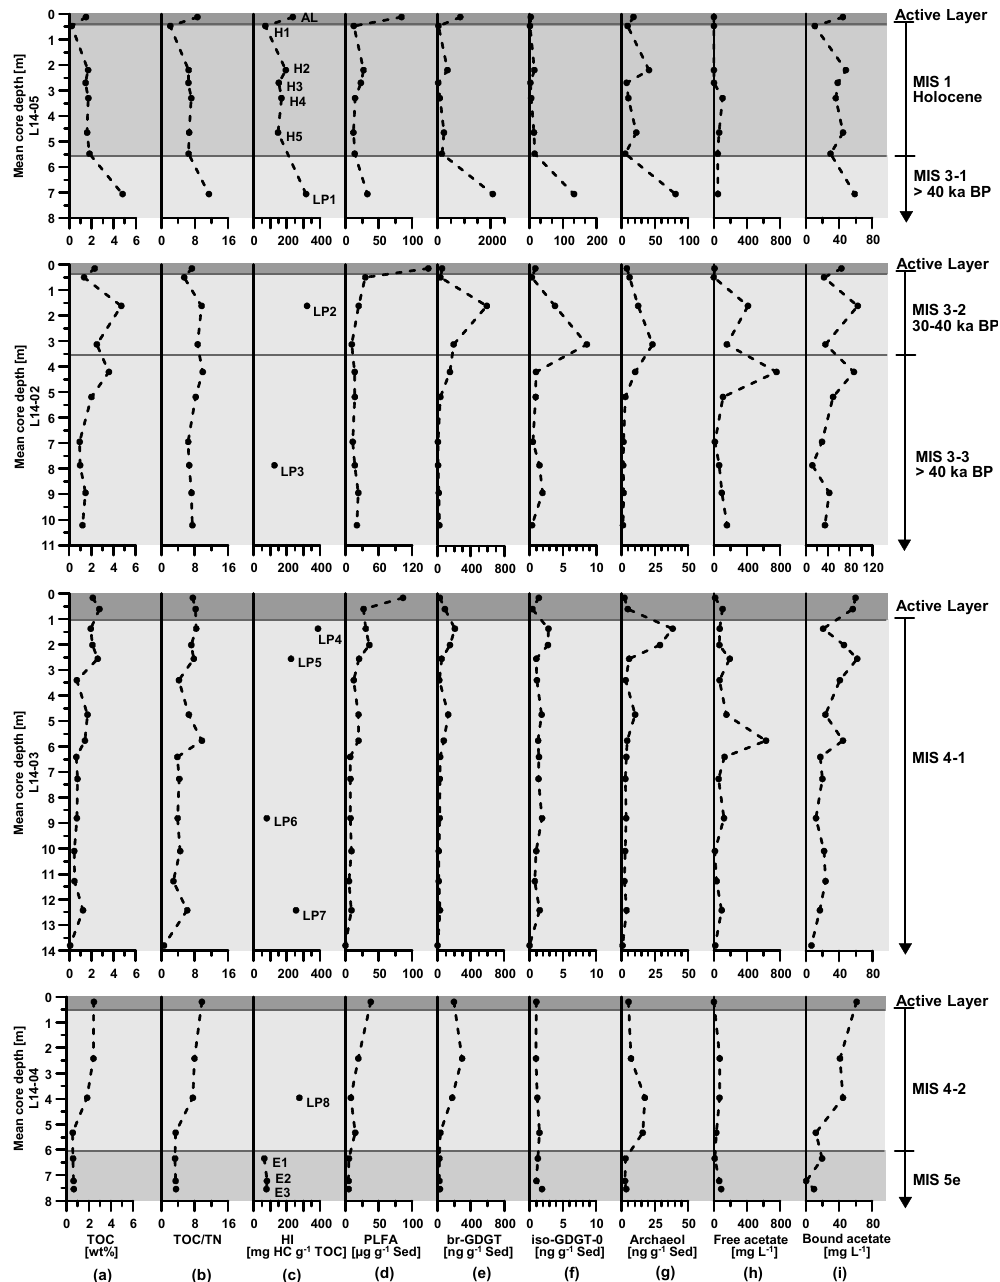
Figure 2. Bio- and geochemical parameters of permafrost cores L14-05, L14-02, L14-03, and L14-04 from Bol’shoy Lyakhovsky Island, northern Siberia, presented with respect to core depth (left axis) as well as stratigraphic and age units (right column). The vertical profiles show (note partly different x axes) (a) the total organic carbon (TOC) content in wt%, (b) the ratio of TOC and total nitrogen (TN), (c) the hydrogen index (HI) in mg HCg − 1 of TOC, (d) the concentration of phospholipid fatty acids (PLFAs) in µgg − 1 of sediment, (e) the concentration of branched glycerol dialkyl glycerol tetraethers (brGDGTs), (f) of isoGDGT-0, and (g) of archaeol, all in ngg − 1 of sediment, and (h) the concentration of free acetate and (i) bound acetate, both in mgL − 1 . Active layer samples are shown in dark grey, interglacial periods (MIS 1 and MIS 5e) in grey, and the last glacial period (MIS 3 and MIS 4) in light grey. According to age, stratigraphy, and core segments, the MIS 3 unit is subdivided into core segments MIS 3-1, 3-2, and 3-3 and the MIS 4 unit into segments MIS 4-1 and 4-2. Sample labels within the HI profile correspond to core samples of different ages (H: Holocene; LP: Late Pleistocene glacial period; E: